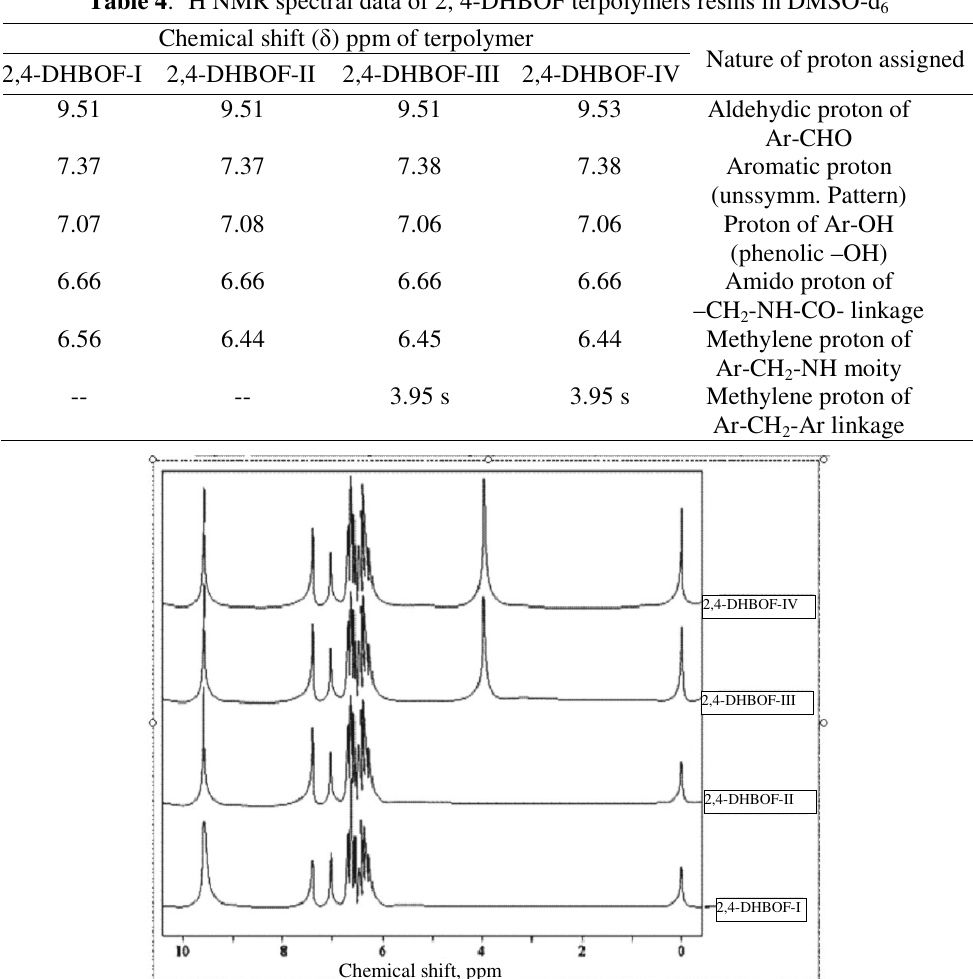
Table 4 . 1 H NMR spectral data of 2, 4-DHBOF terpolymers resins in DMSO-d